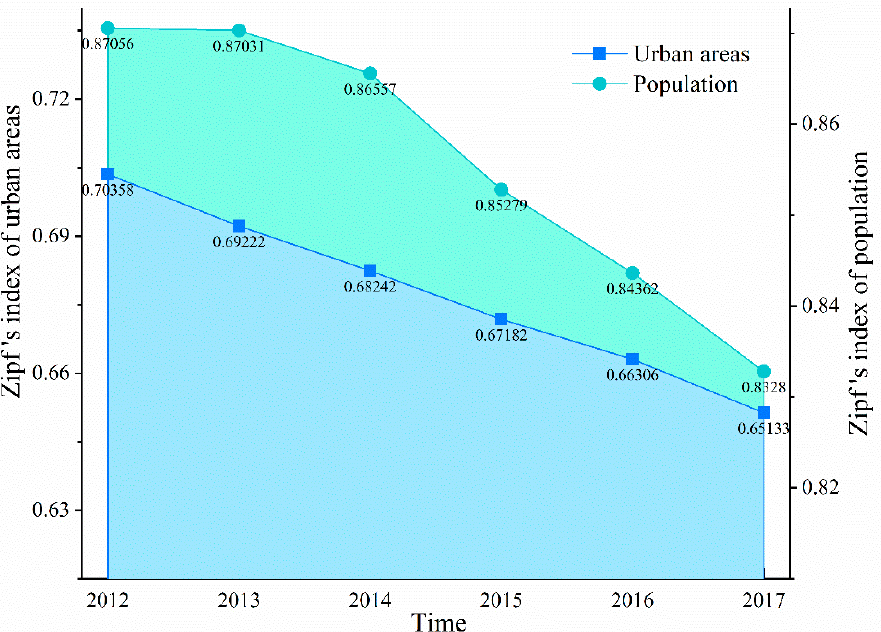
Figure 6. Variations in Zipf’s index for the extracted urban areas and the statistical population data of the YRD from 2012 to 2017.